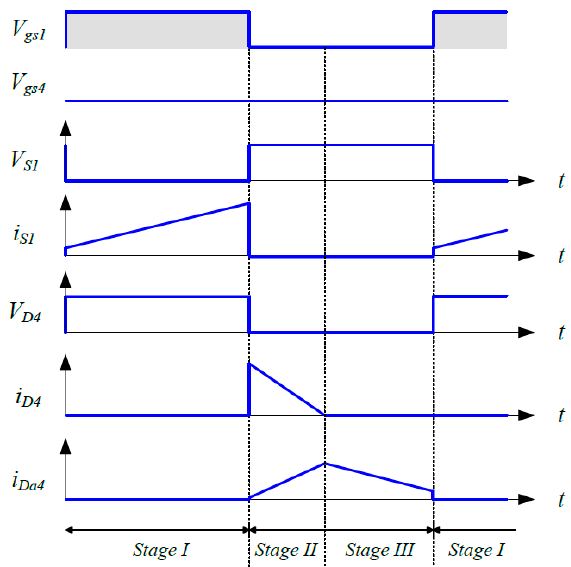
Figure 5. Steady-state operation waveforms corresponding to the switching circuit diagrams of the proposed inverter during T s for positive cycle of the phase voltage e a